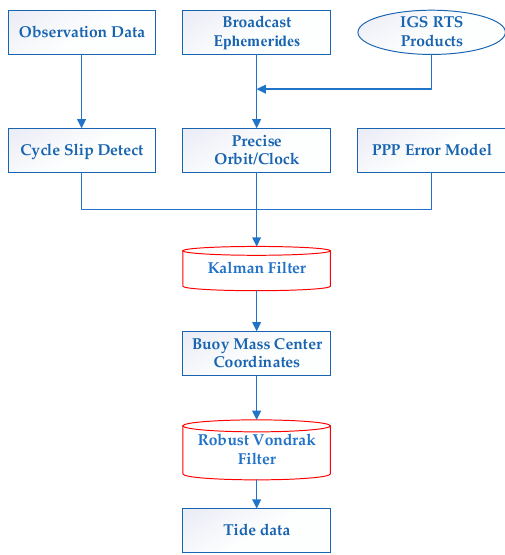
Figure 1. Flow chart of real-time tide measurement using real-time precise point positioning (RT-PPP) based on IGS real-time service (RTS) products.